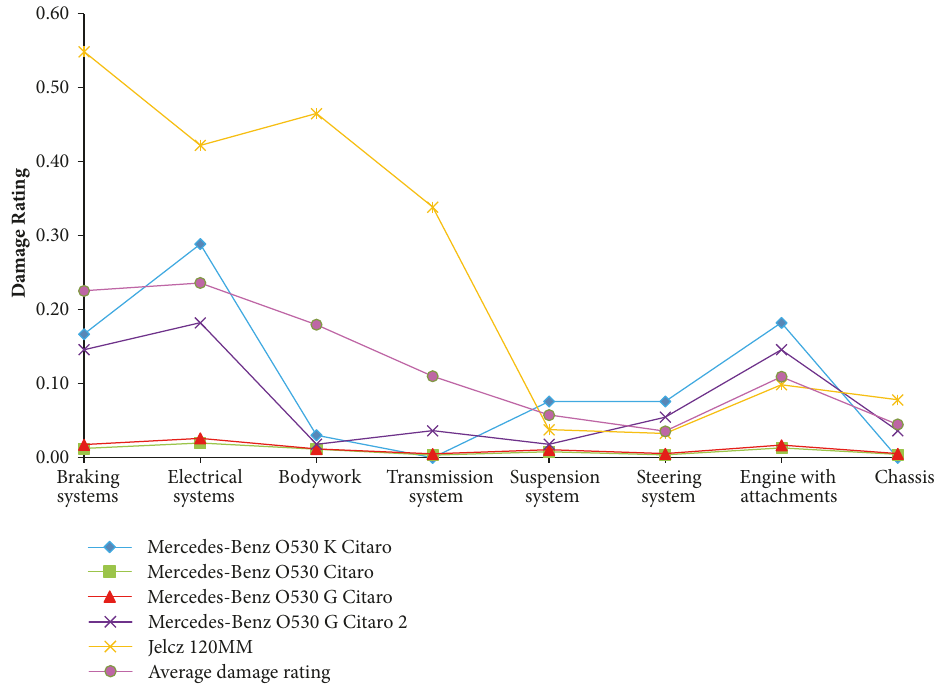
Figure 3: Damage indicators of individual buses of MPK operator